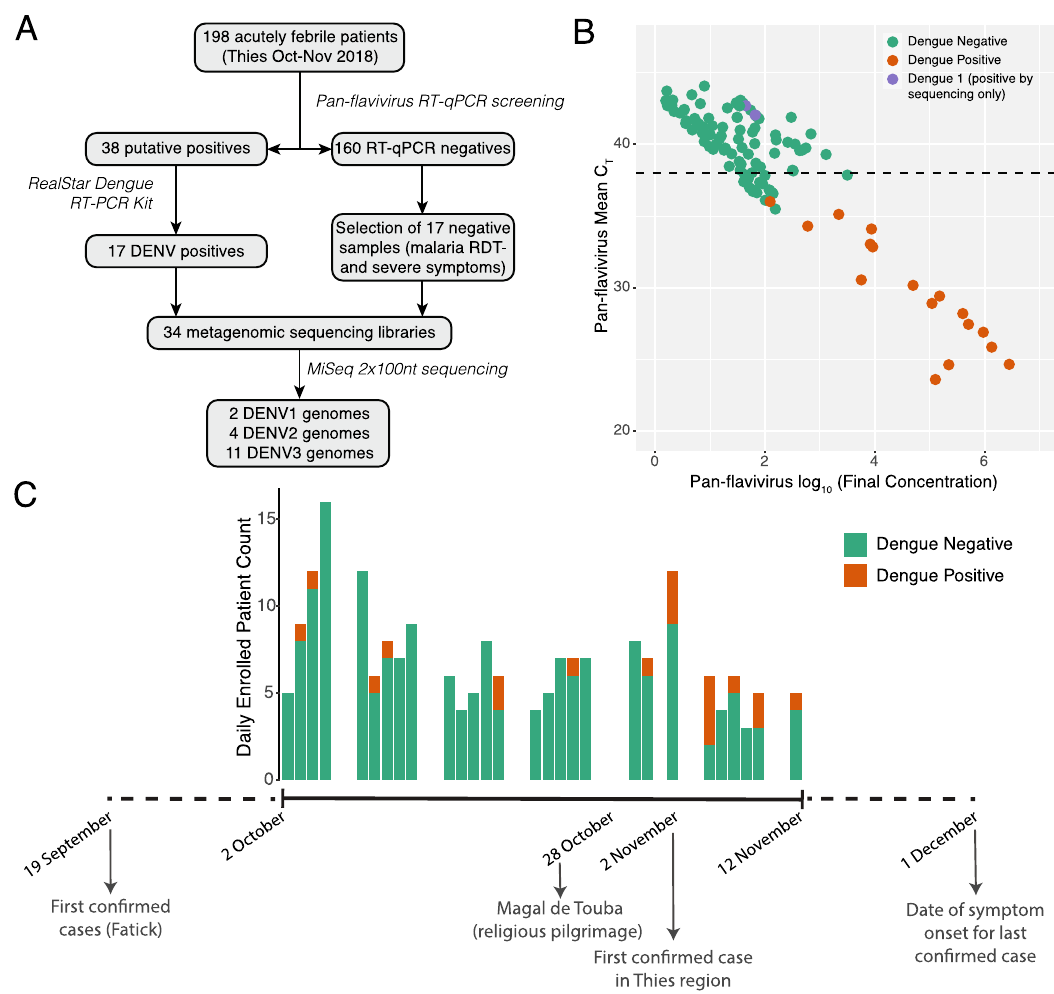
Figure 1. Detection of dengue virus in individuals with acute fever. ( A ) Flowchart of the study showing the major assays performed and numbers of samples at each step. ( B ) Plot showing the CT and viral concentration of all 198 samples tested. Dengue-positive samples, as determined by the RealStar assay, are colored in orange, and DENV1 samples identified by sequencing only are colored in purple. The CT cutoff used to identify putative positives for further testing is shown by a black dashed line. ( C ) Timeline of the 2018 dengue virus outbreak in Senegal showing the number of patients enrolled per day and the number of individuals that tested positive for dengue. Below the plot are marked several important events during the